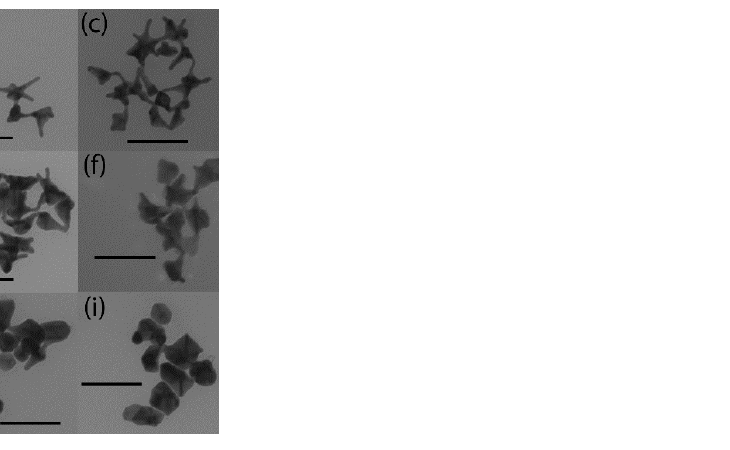
Figure 2. Representative TEM images of ( a ) GNS, ( b ) GNS@Ag75, ( c ) GNS@Ag150, ( d ) GNS@Ag225, ( e ) GNS@Ag300, ( f ) GNS@Ag375, ( g ) GNS@Ag450, ( h ) GNS@Ag525, ( i ) GNS@Ag600. Scale bar: 100 nm.